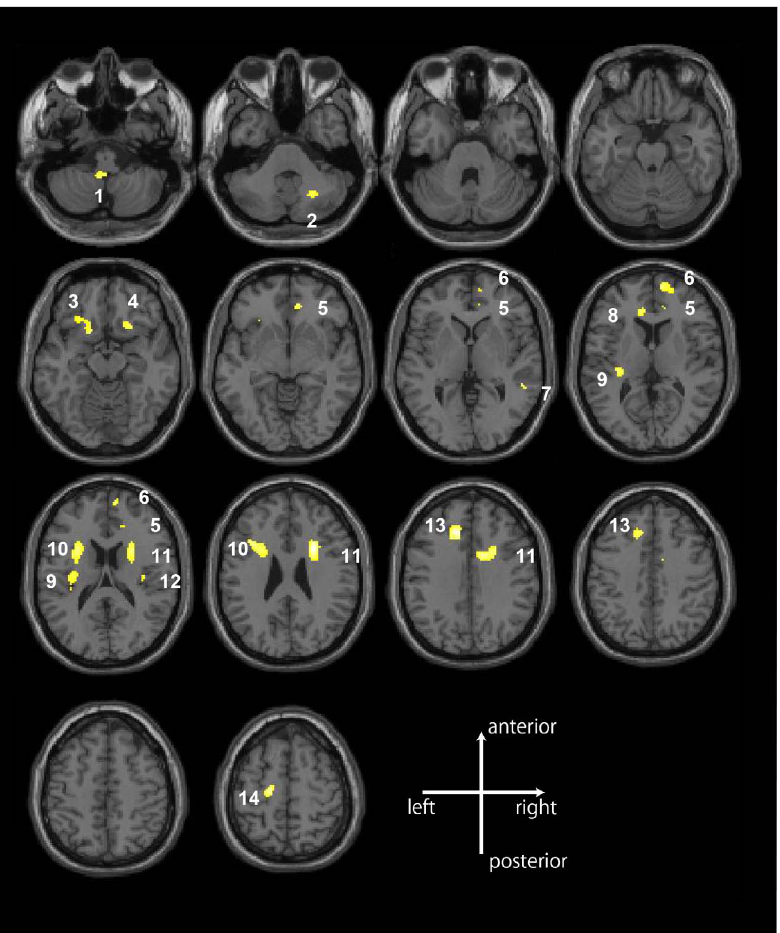
Figure 1. White matter volume reductions in the patients with panic disorder compared with the healthy control subjects. The patients with panic disorder had significant volume reductions in 14 distinct white matter regions (clusters) compared with the healthy control subjects (p , .05, FDR-corrected). The 14 white matter regions included fronto-limbic regions (bilateral OFG, right superior frontal gyrus, left precentral gyrus, bilateral cingulum, and insula), thalamo-cortical pathways (anterior and superior corona radiata), right superior and middle temporal gyrus, and the cerebellum.